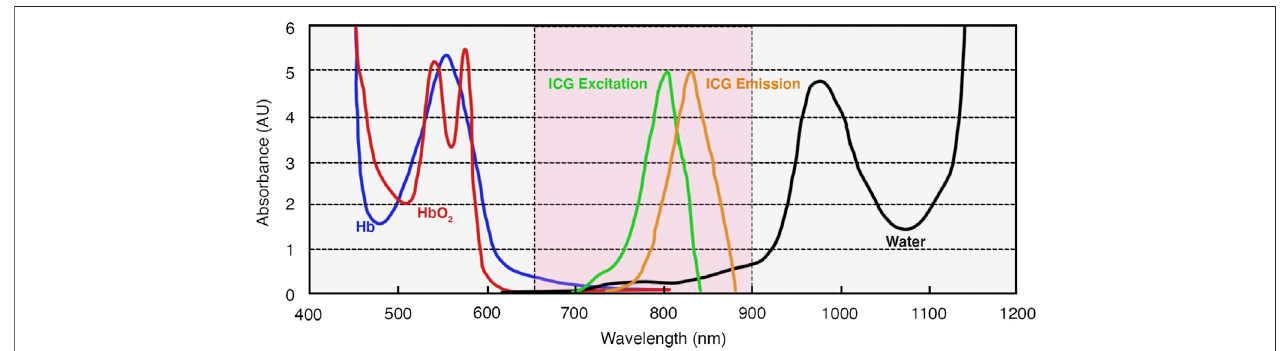
FIGURE 5 | Optical characteristics of ICG and absorption spectra of hemoglobin and water. Based on information from Miwa (2016). The area in pink represents the “ optical window ” (650 – 900 nm) of the far-red/NIR-I spectrum for optimum in vivo imaging. Abbreviations: AUs, absorbance units; ICG, indocyanine green; Hb, deoxygenated hemoglobin; HbO 2 , oxygenated